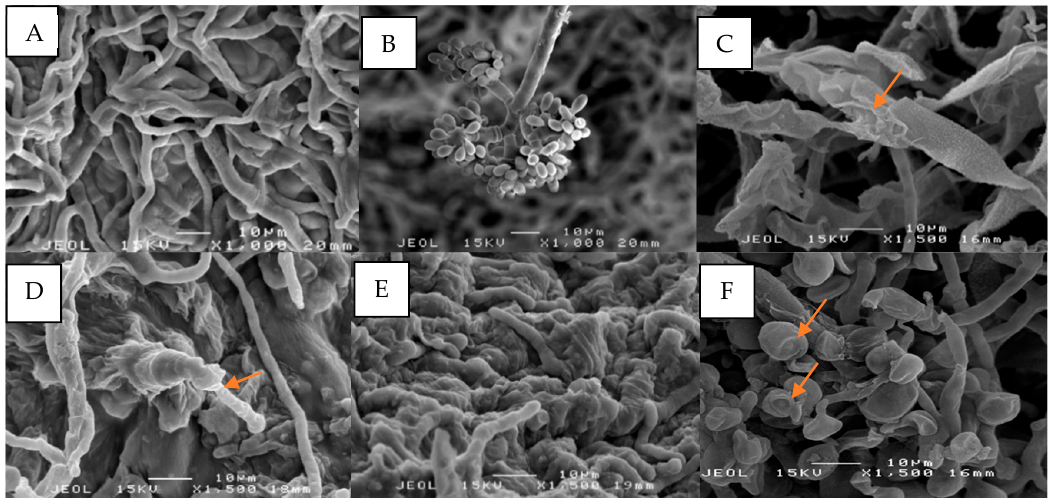
Figure 3. Effects of dichloromethane (DCM) crude extract on B. cinerea at 400 and 500 mg/mL on mycelium morphology viewed under SEM. ( A ) Healthy mycelium are slender and uniform, with a smooth surface and an intact structure in the control plate; ( B ) Healthy conidiophore from the control plate; ( C ) Mycelia were ruptured, folded with edge burrs, and sheet ‐ like structure at 400 mg/mL; ( D ) The hyphae tip was wrinkled and deformed at 400 mg/mL; ( E ) Agglutinated mycelia at 500 mg/mL; ( F ) The conidia were shrunken at 400 mg/mL.